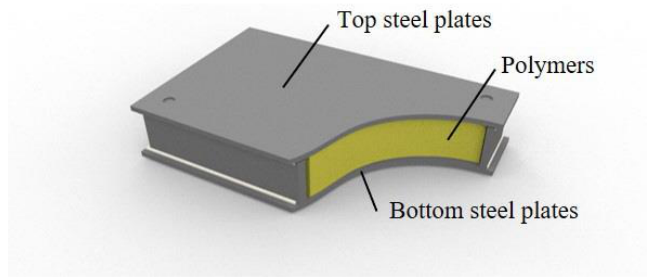
Figure 1. Steel–polymer composite floors.